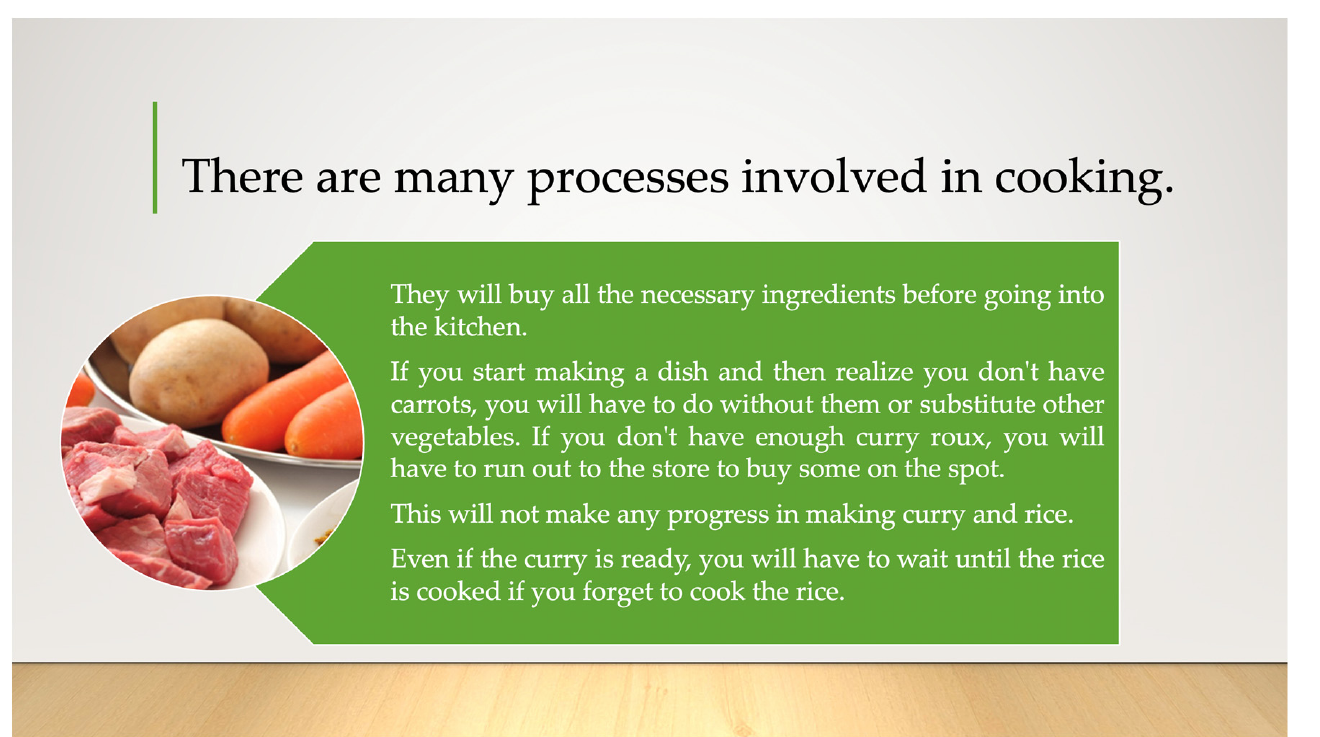
Figure 1. Excerpts from actual lecture materials.